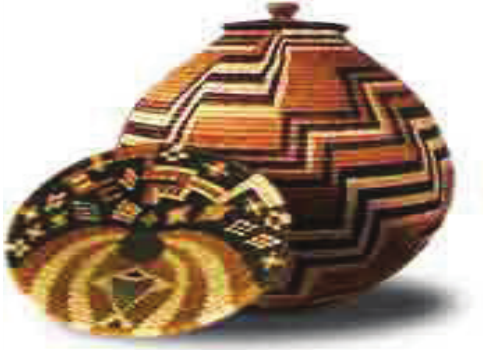
Figure 4: Traditional